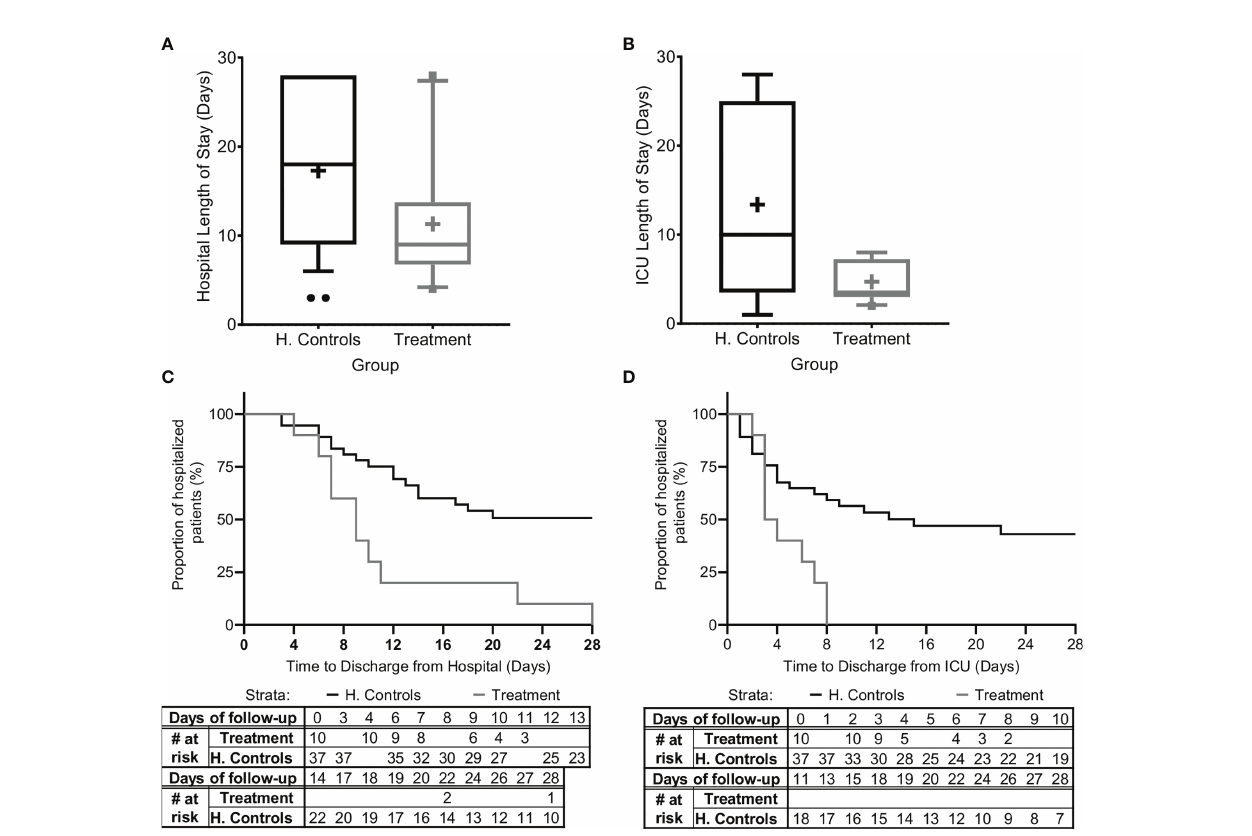
FIGURE 4 | Hospital and ICU/IMU duration of stay. The duration of stay for all patients in the study and for all patients in the matched historical control group who survived is presented (A) in the hospital and (B) in the Intensive Care Unit (ICU) or the Intermediate Medical Unit (IMU). Kaplan-Meier curves describing time-to- discharge from the (C) hospital and (D) ICU/IMU are presented. Matched controls were selected from all patients admitted to ICU/IMU with the diagnosis of sepsis between 2014 – 2019 and were matched by gender, age ±7, SOFA score ±2 at presentation, and source of infection. Data is presented as the median within the interquartile range (IQR); mean values are marked with a ‘ + ’ sign; error bars represent the 10 – 90 percentile, with outliers